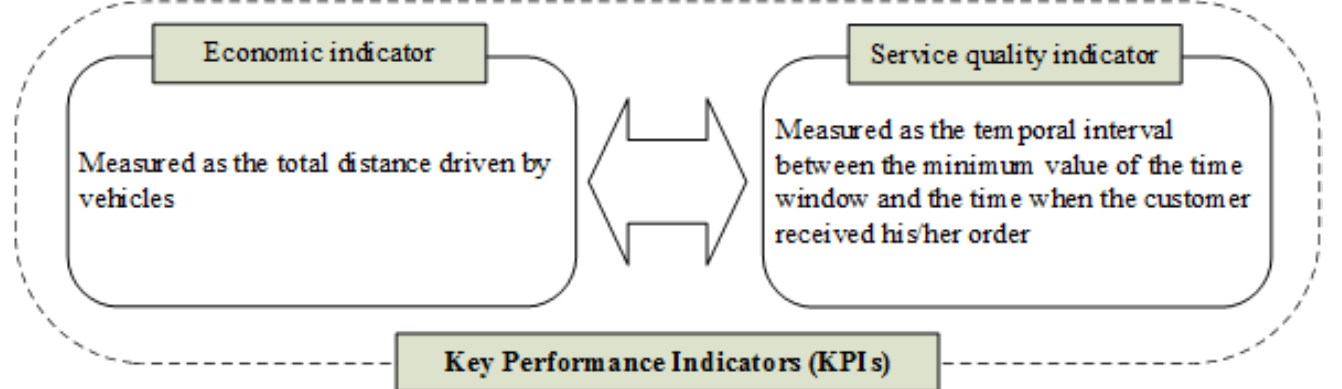
Figure 4. Key Performance Indicators for evaluating horizontal